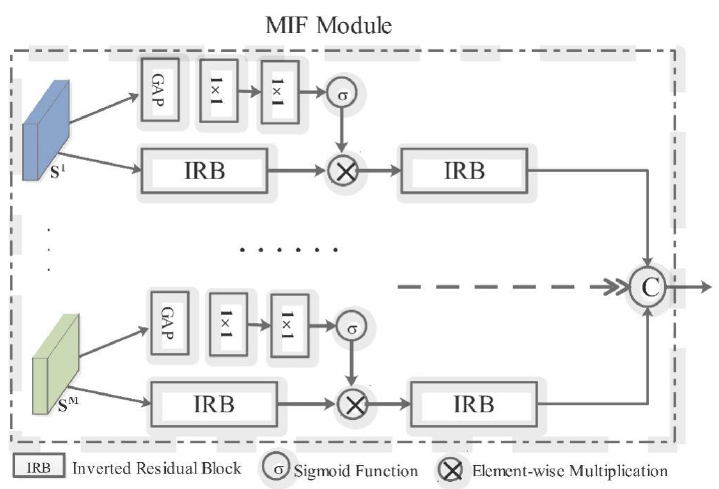
Figure 5. Multi-instance fusion module.